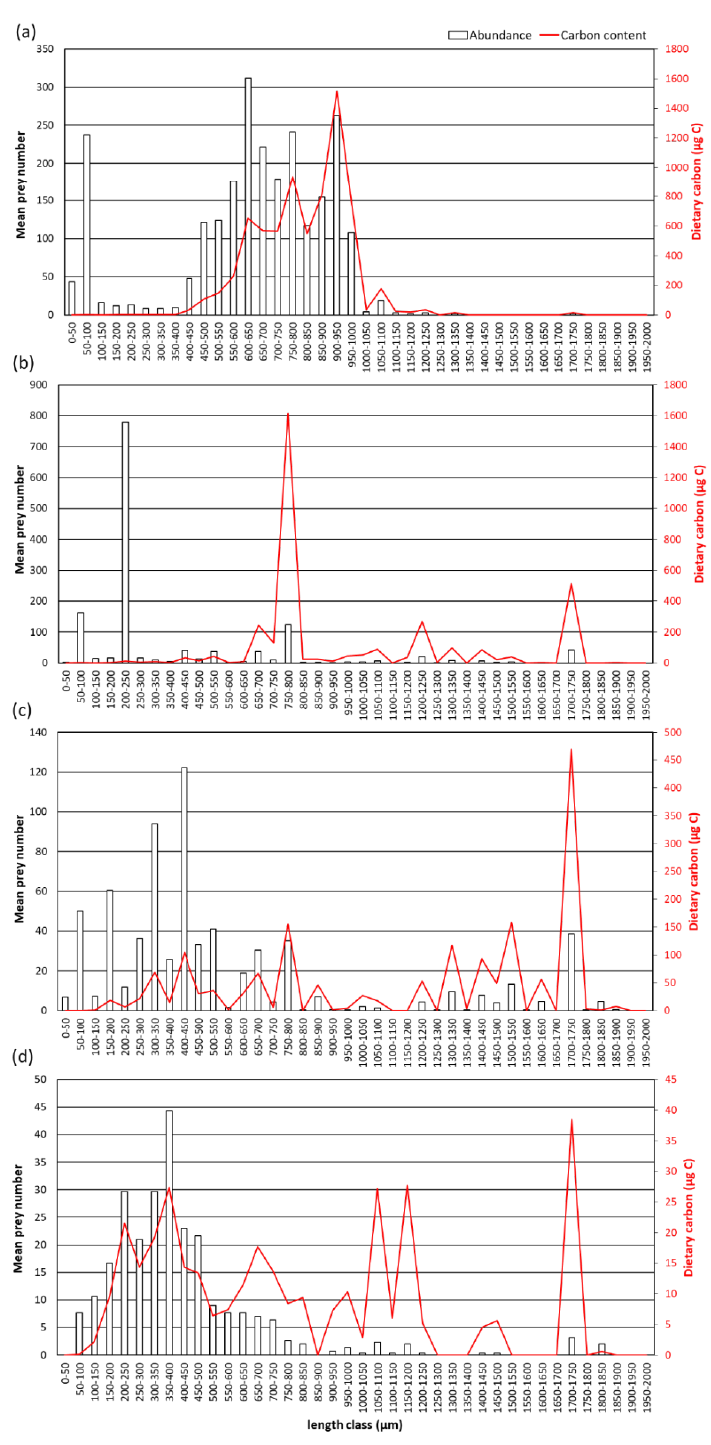
Figure 5. Distribution of small prey (<2 mm size) in gut contents: mean counted prey/stomach by size classes of 50 µ m (histograms) and their relative carbon content (red solid line) in ( a ) May, ( b ) June, ( c ) July and ( d )